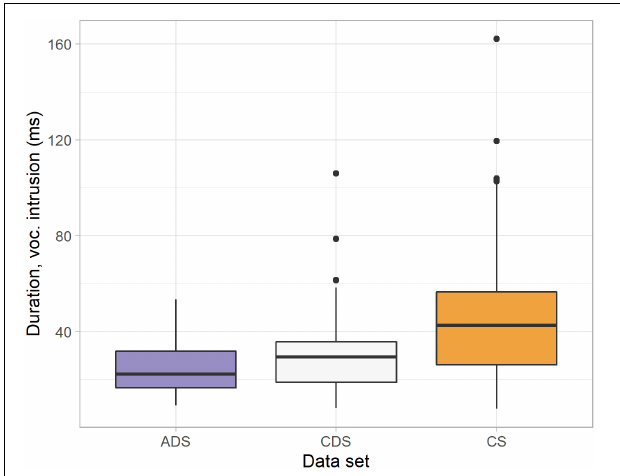
FIGURE 2 | The duration of vocalic intrusions in consonant clusters produced in ADS, CDS, and